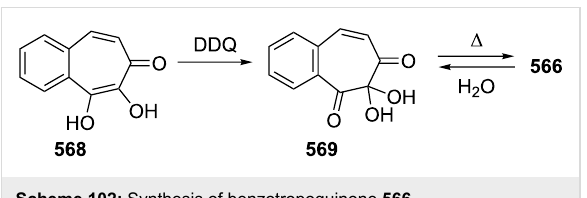
Scheme 102: Synthesis of benzotropoquinone 566 .